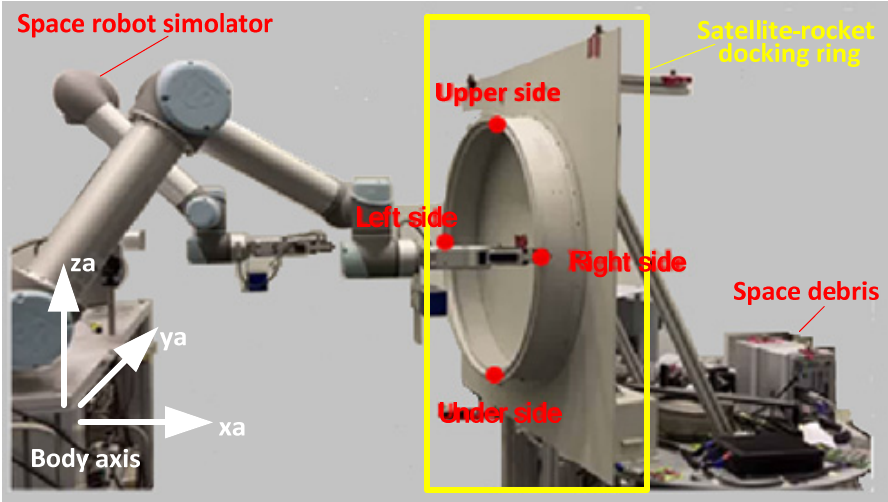
Figure 4. Control flow of the model-free control method.